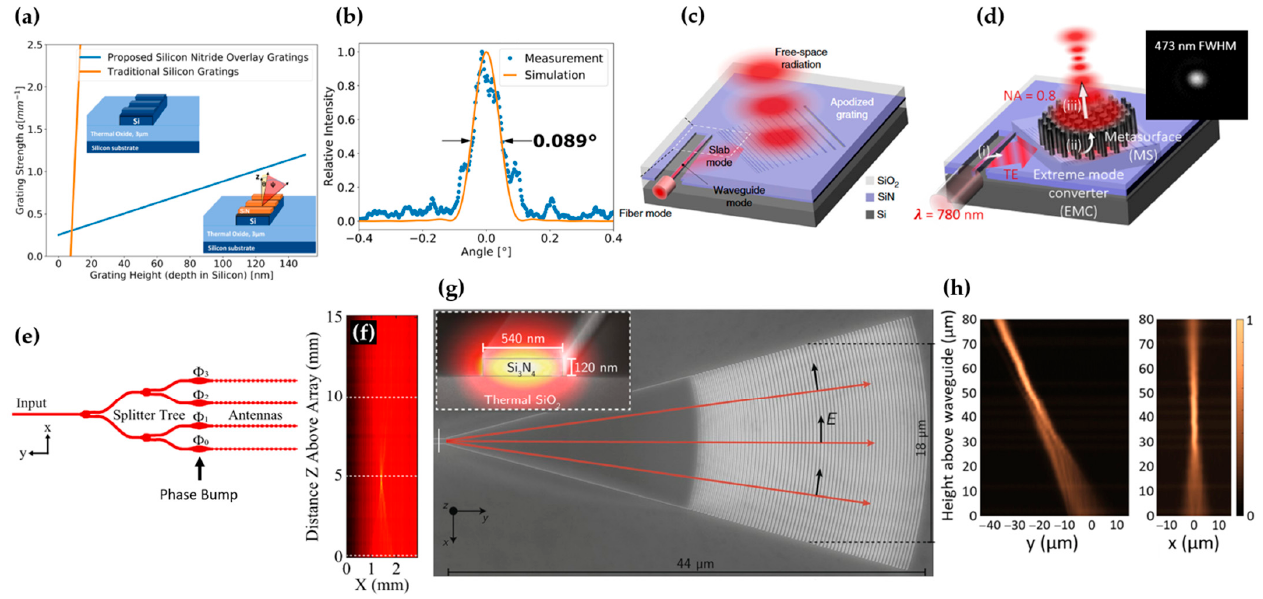
Figure 10. ( a ) Simulation of the grating strength of a grating formed by etching into a 250 nm × 450 nm silicon waveguide (orange) and by etching a 120 nm SiN overlay on the same silicon waveguide (blue) [54]. ( b ) Far-field measurement of a 1 mm-long SiN-overlay grating with an apodized duty cycle. Reprinted with permission from [54] © The Optical Society. ( c ) Schematic of a 2D beam expander [70] © 2022, Kim et al. ( d ) Beam focusing using a metalens on top of a 2D beam expander. Inset: optical image of the focused spot. Adapted with permission from [73] © 2022 American Chemical Society. ( e , f ) Schematic and measured cross-sectional intensity of an OPA designed for beam focusing. Reprinted, with permission, from [76] © 2022 IEEE. ( g , h ) SEM image and measured beam profiles of a grating coupler designed for beam focusing [79] © 2022 Mehta et